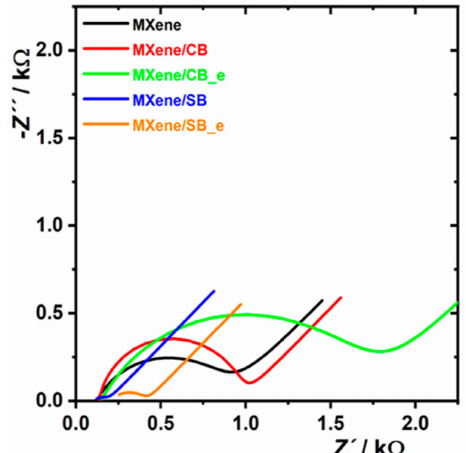
Figure 6. EIS investigation performed on MXene-modified electrode and on the electrode patterned by zwitterion-modified MXene. For other experimental conditions see Figure 5. EIS analysis is shown as a Nyquist plot using an equivalent circuit R [ Q ( RW )] for data fitting. Abbreviations: MXene / CB: MXene spontaneously modified by carboxybetaine; MXene / SB: MXene spontaneously modified by sulphobetaine; MXene / CB_e: MXene modified by carboxybetaine using a redox trigger; MXene / SB_e: MXene modified by sulphobetaine using a redox trigger. The figure is reprinted from our open access paper